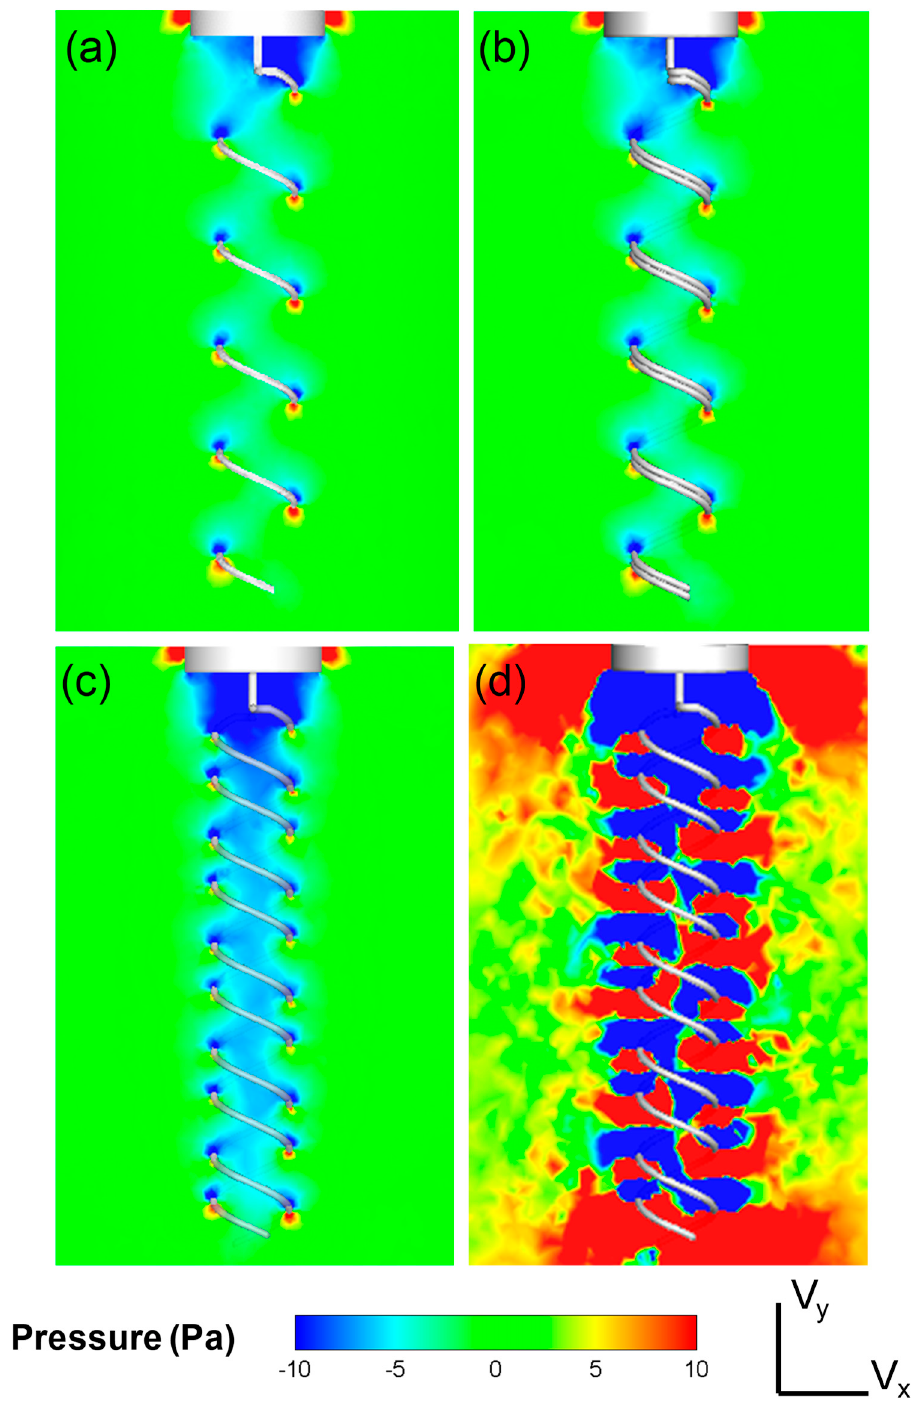
Figure 8. Pressure contours are plotted at the center-plane along the flagella axis for ( a ) single flagellum, ( b ) in-phase, ( c ) out-of-phase double flagella configurations inside less viscous oil (350 cSt) and ( d ) out-of-phase double flagella inside high viscous oil (30,000 cSt). Pressure drop across the flagella increased slightly for the out of-phase configuration and notably for the high viscous case compared to the single flagellum.